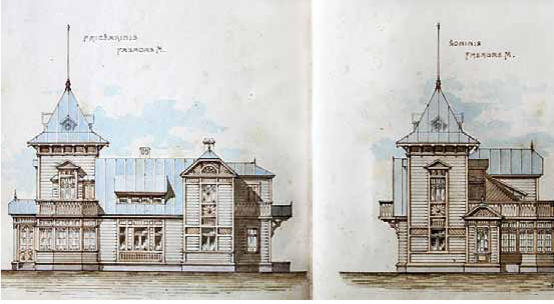
figs. 11, 12. Wooden houses with authentic architecture at Zemuogiu St. 2 (included in the register of Cultural Properties) and at Smetonos av.